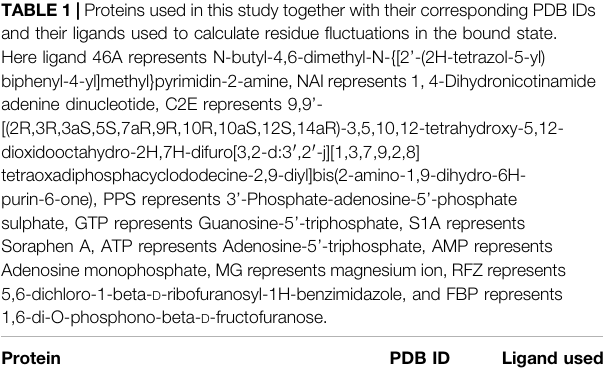
( Figure 3E ), Acetyl-Coenzyme A carboxylase ( Figure 3F ),